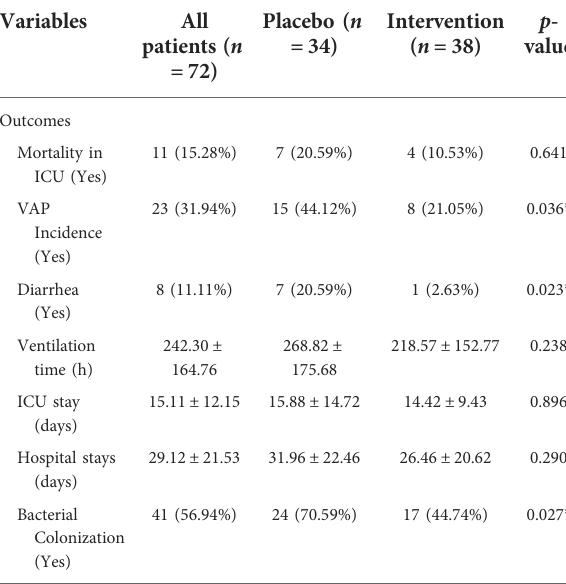
TABLE 3 Outcome